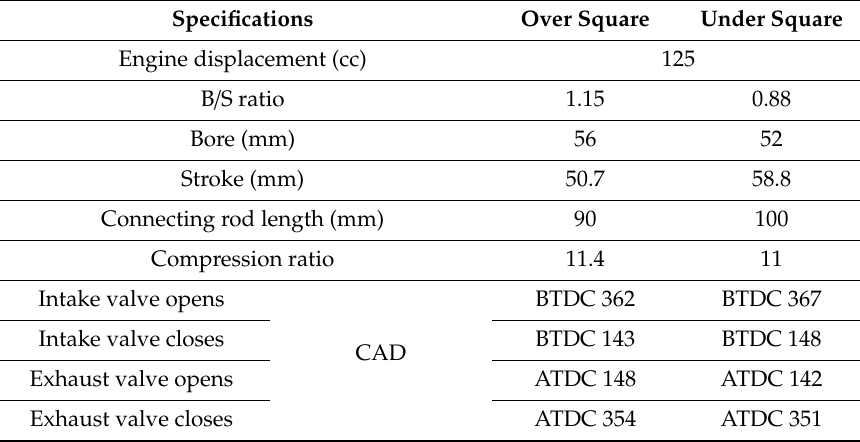
Table 2. Test fuel properties.